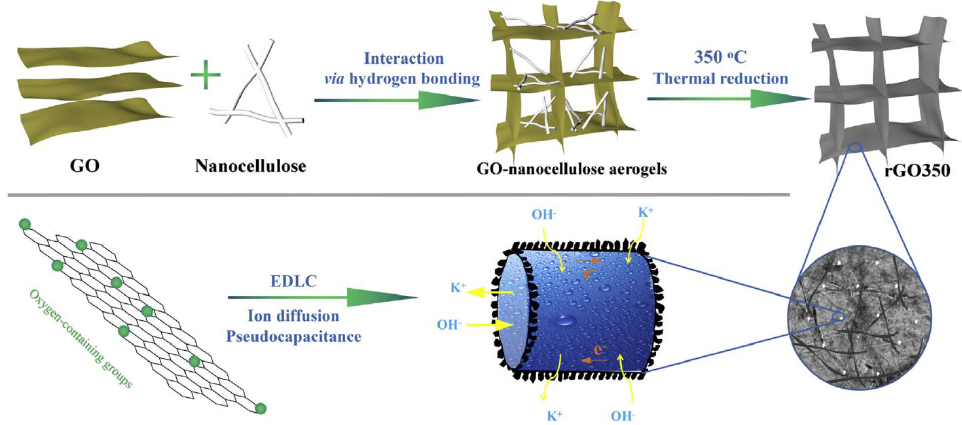
Figure 7. Schematic representation of the synthesis and ionic and electronic transport research mechanisms of rGO aerogel as a capacitor electrode within a KOH electrolyte. Reprinted with permission from ref. [115]. 2017 Elsevier.